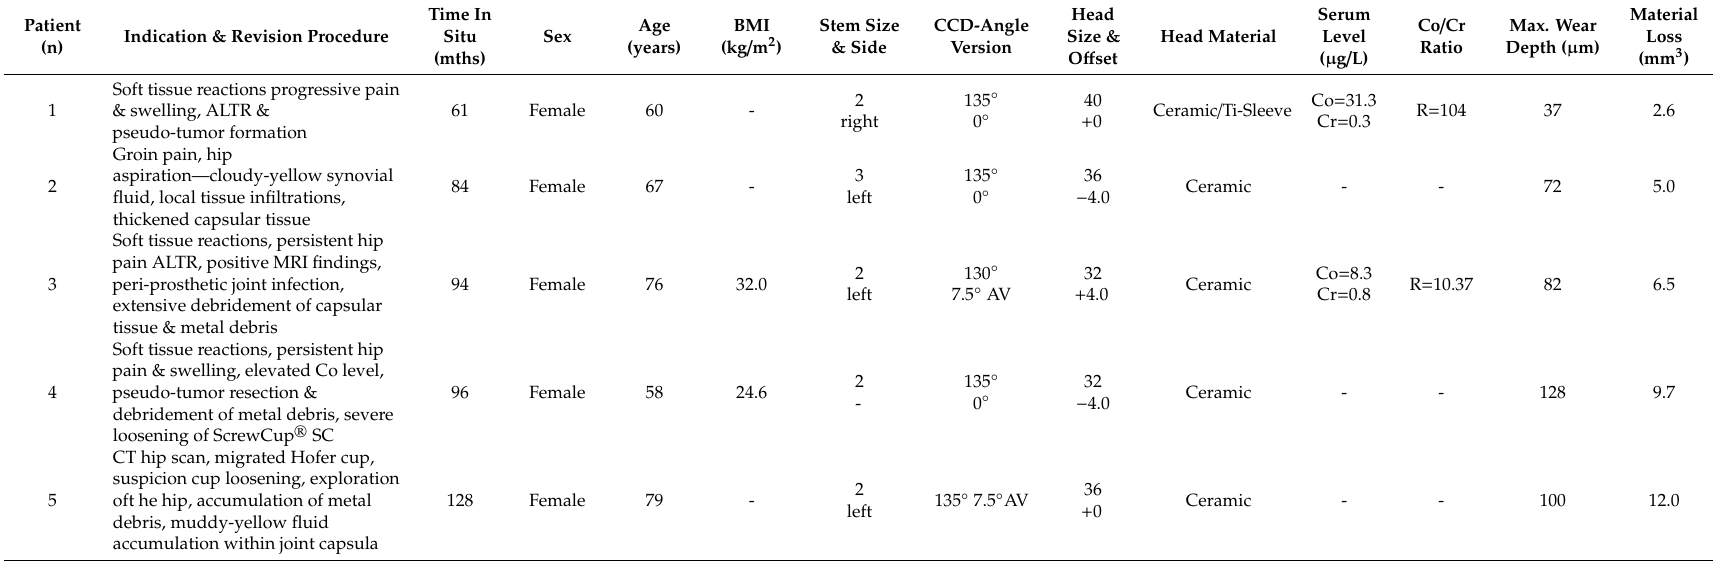
Table 2. Overview of five symptomatic clinical cases with retrieved Metha ® CoCr dual taper neck